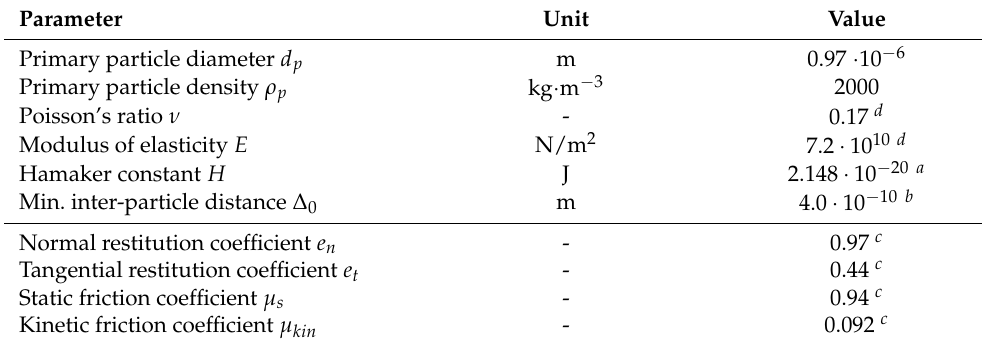
Table 2. Properties and other characteristic parameters of the considered silica particles (SiO 2